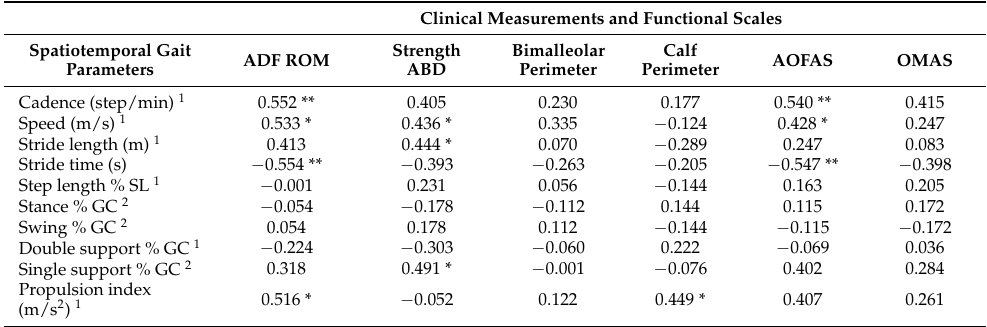
Table 4. Correlation between clinical measurements and functional scales with the spatiotemporal gait parameters in operated ankle.